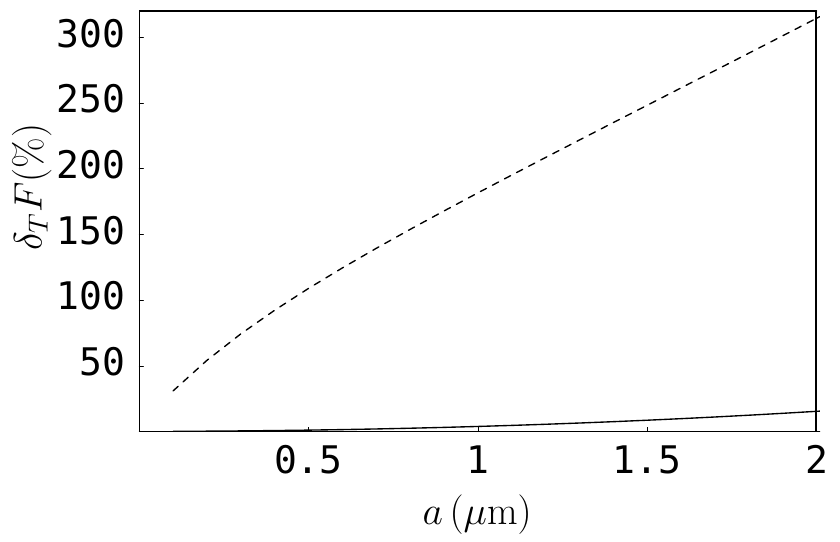
Figure 4. The relative thermal corrections for the Casimir force between fused silica plates computed in the framework of Lifshitz theory at T = 300 K with taken into account and omitted DC conductivity as functions of separation are shown by the dashed and solid lines,